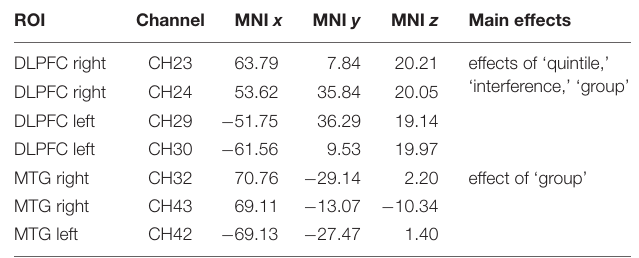
TABLE 5 | Quantile analysis. TABLE 6 | Regions of interest